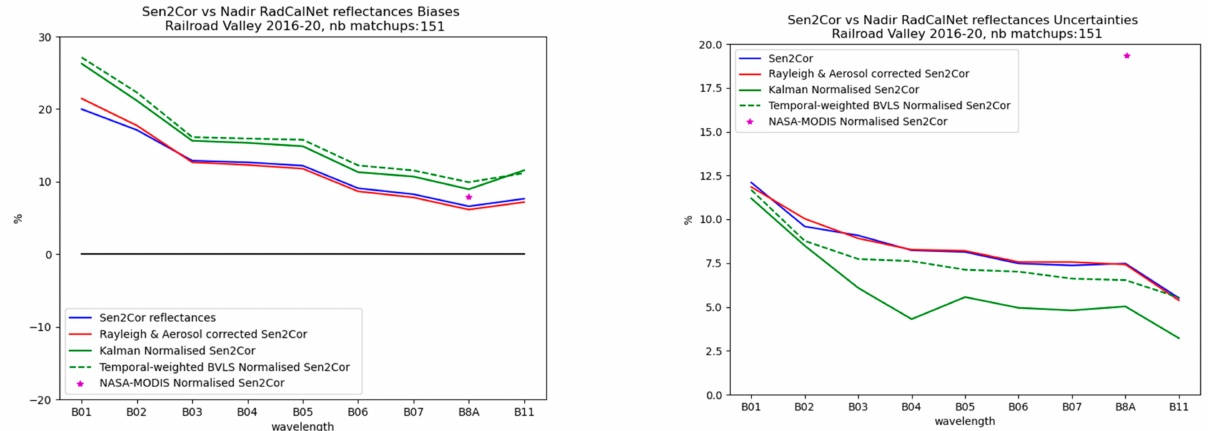
Figure 4. Statistical assessment of normalized Sen2Cor reflectances vs. in-situ data using the Ross-Li kernels at Railroad Valley. Left, accuracy (biases) and right, uncertainties. The red stars correspond to the normalization results obtained using directly the MODIS band 2 BRDF MCD43A1 (500 m res.) parameters and the related Ross-Li